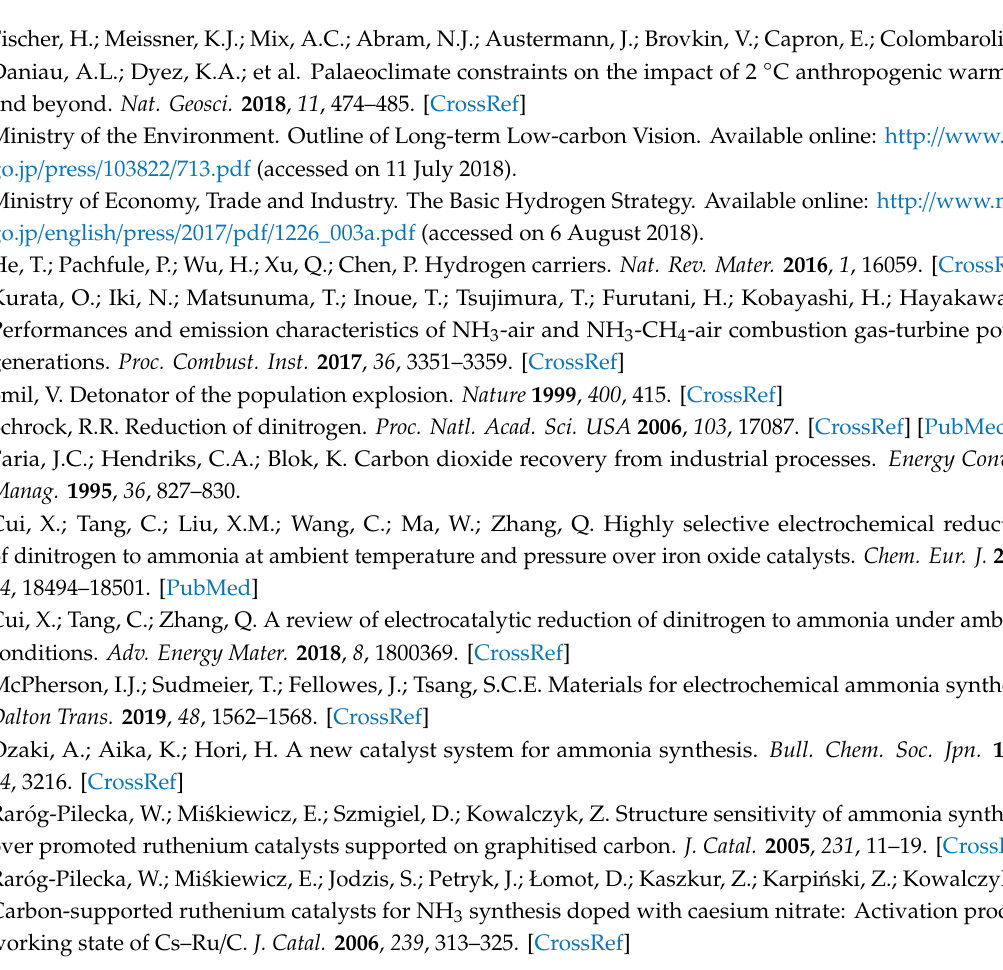
Figure S1: HRTEM images of the prepared Ba-Ru catalysts and reference materials: ( a ) 1.6Ba-10Ru / AC, ( b ) 1.6Ba-10Ru / MPC, ( c ) 1Ba-10Ru / MPC, ( d ) 0.5Ba-10Ru / MPC, ( e ) 0.1Ba-10Ru / MPC, ( f ) 10Ru / MPC, and ( g ) 1.6Ba / MPC., Figure S2: Ru size distributions of the prepared Ba-Ru catalysts: ( a ) 1.6Ba-10Ru / AC, and ( b ) 1.6Ba-10Ru / MPC., Figure S3: HAADF-STEM images of the fresh 1.6Ba-10Ru / MPC